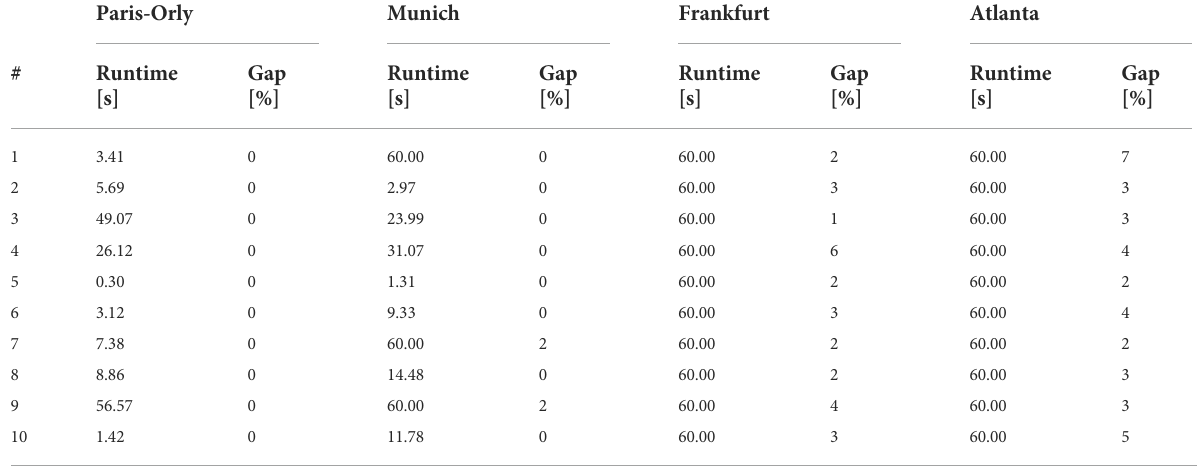
TABLE 5 Solver runtimes in seconds and corresponding branch-and-bound gaps with no prede fi ned gap and time budget of 60 s. Paris-Orly Munich Frankfurt